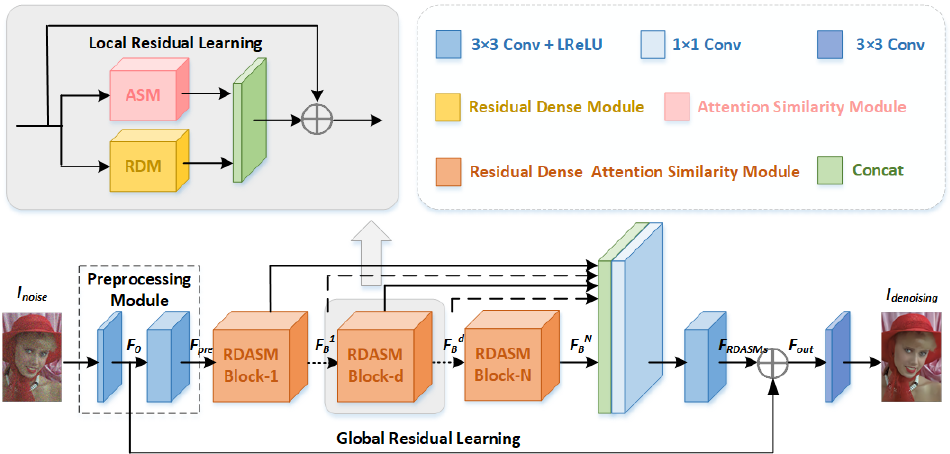
Figure 1. Network architecture of the proposed